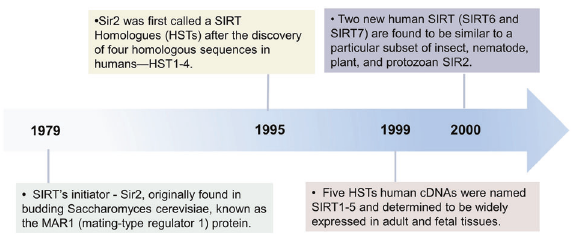
Fig. 1 The historical timeline on milestones in SIRT family